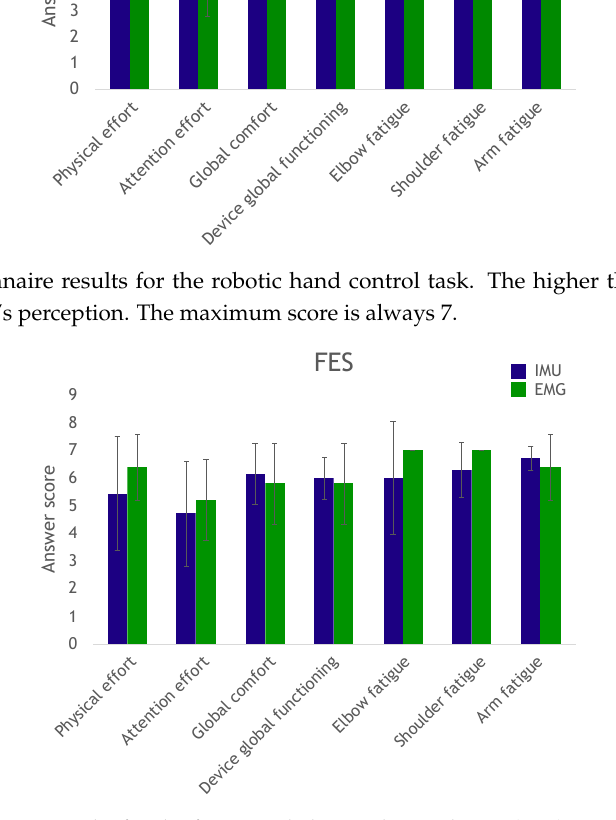
Figure 9. Questionnaire results for the functional electrical stimulation (FES) control task. The higher the value, the more positive or easier the subject’s perception. The maximum score is always